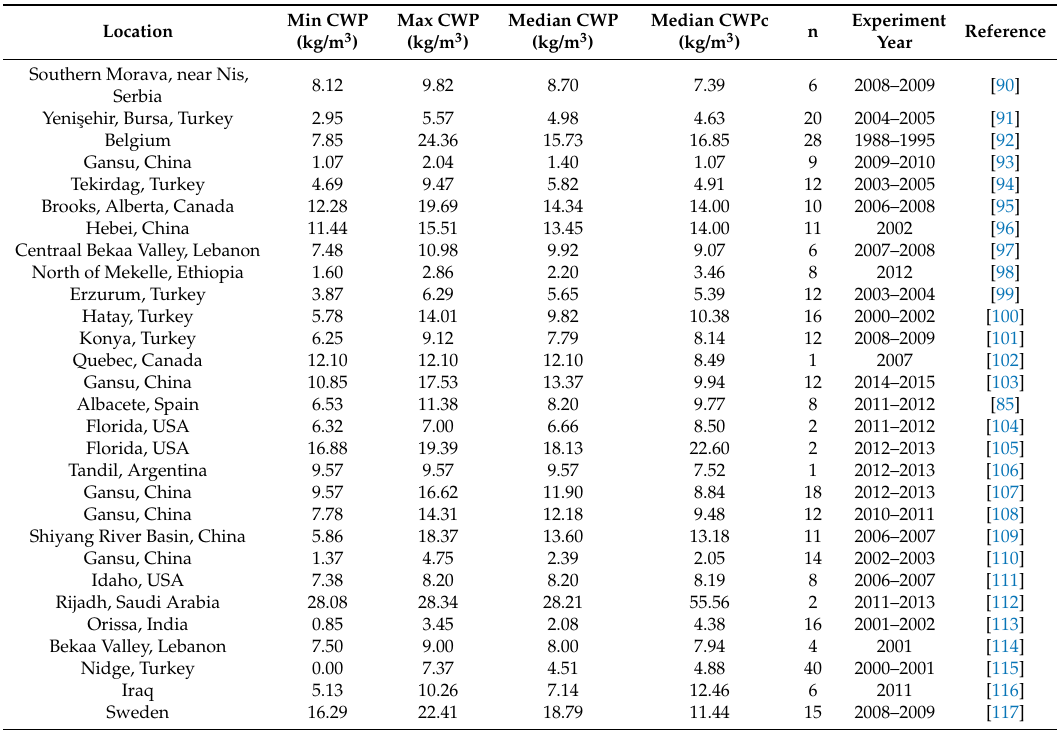
Table A1. CWP and CWPc values from literature used to estimate GWPS and LWPS scores on the global